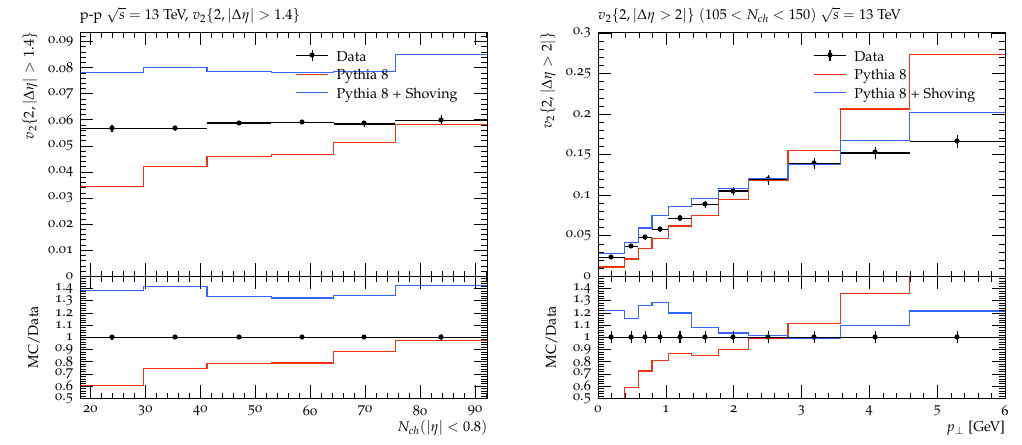
Figure 13 . Comparison to v 2 { 2 } as function of multiplicity with ALICE high multiplicity trigger (left), and versus p ⊥ in high multiplicity events (right). Data from pp collisions at ALICE [98] and CMS